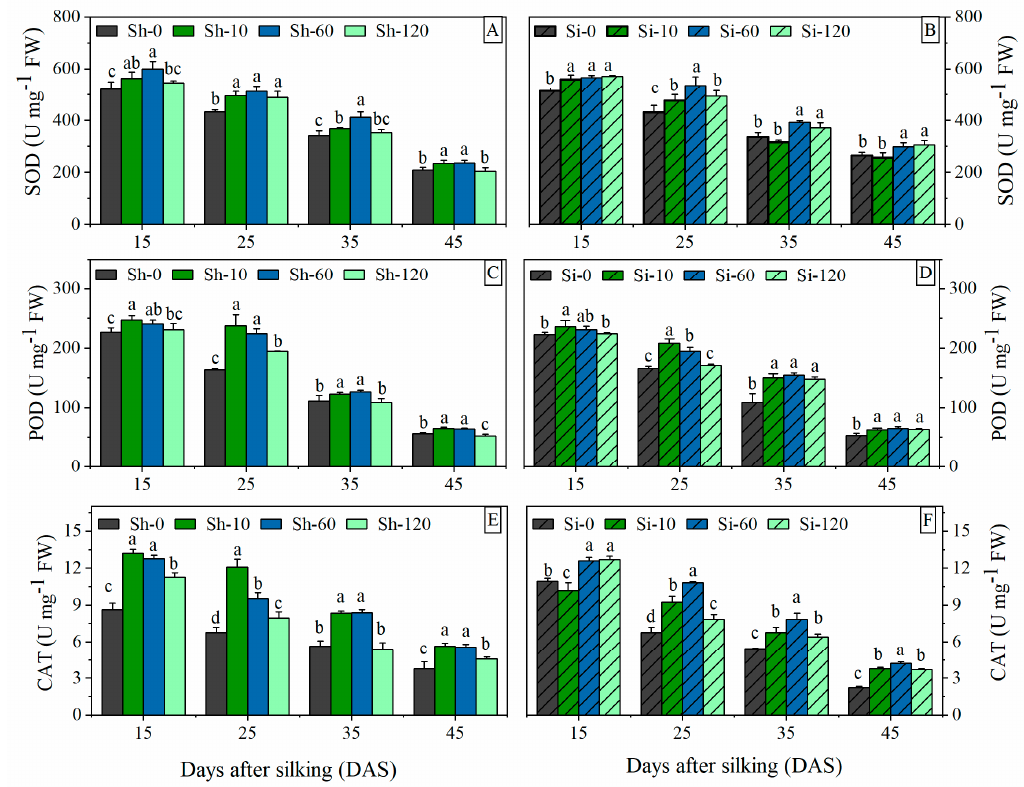
Figure 4. E ff ects of GA 4 + 7 applications on SOD, POD and CAT activities in maize. Sh-0, Sh-10, Sh-60 and Sh-120 represent shank-treatments with GA 4 + 7 at the rates of 0, 10, 60, and 120 mg L − 1 , respectively. Figure 4. Effects of GA4+7 applications on SOD, POD and CAT activities in maize. Sh-0, Sh-10, Sh-60 Si-0, Si-10, Si-60 andSi-120 represent silk-treatments with GA 4 + 7 at the rates of 0, 10, 60, and 120 mg L − 1 . The vertical bars represent the ± the standard error of the mean (n = and Sh-120 represent shank-treatments with GA4+7 at the rates of 0, 10, 60, and 120 mg L-1, respectively. Si-0, Si-10, Si-60 andSi-120 represent silk-treatments with GA4+7 at the rates of 0, 10, 60, and 120 mg L-1. The vertical bars represent the ± the standard error of the mean (n = 3).